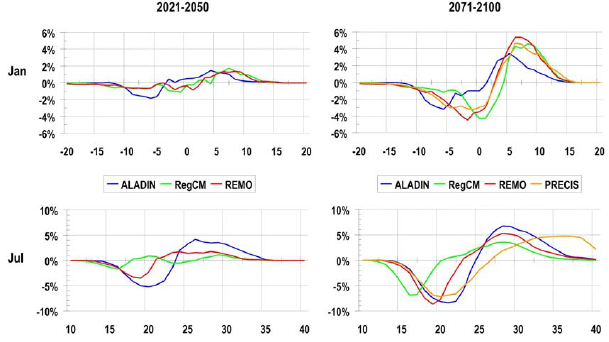
Fig. 3. Changes of probability density function for daily temperature values over Hungary for 2021–2050 and 2071–2100 relative to 1961–1990.